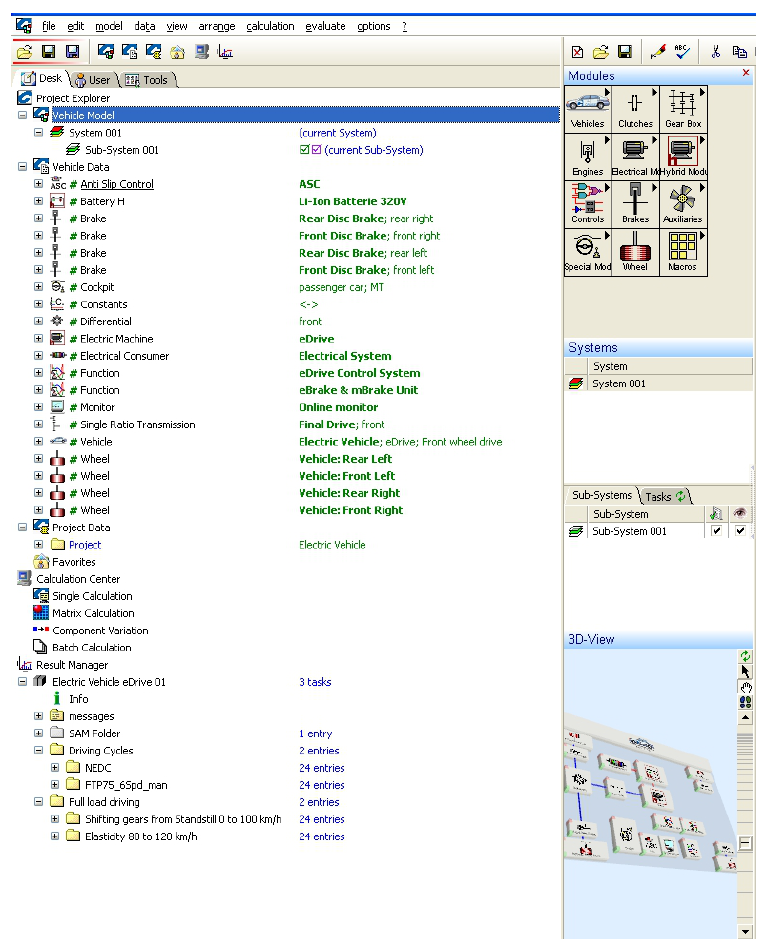
Figure 2. The tree structure of elements of the electric vehicle.